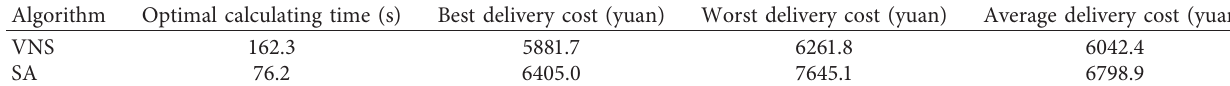
Table 4: Comparison of optimization results for two algorithms.